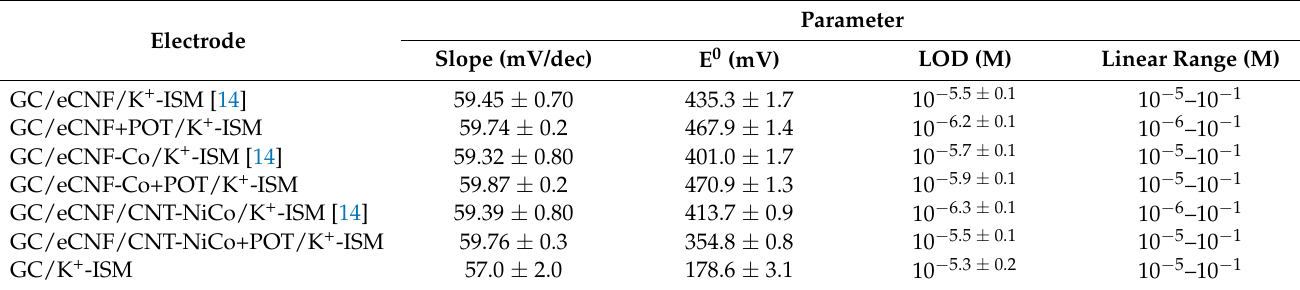
Table 3. Potentiometric parameters of the investigated K + -ISEs.